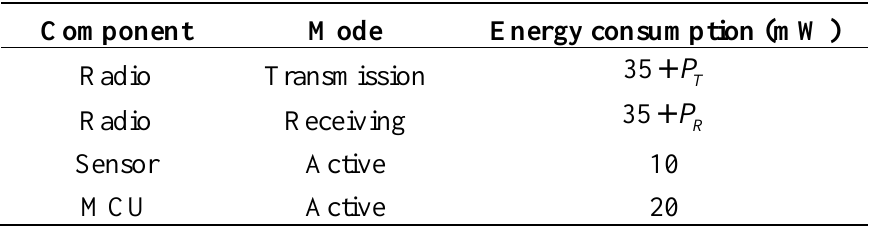
Table 1 . Energy consumed by different components of a sensor node.